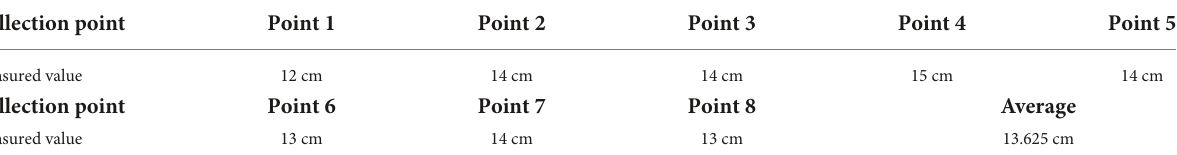
TABLE 4 Navigation accuracy test value of each sampling point (Group 1).